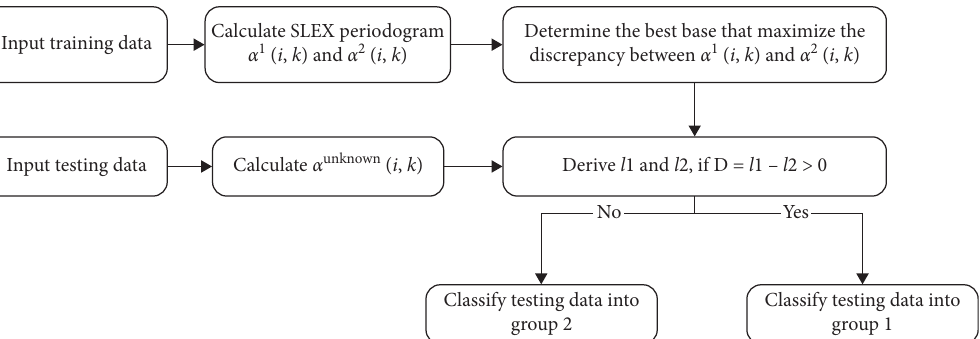
Figure 2: Flowchart of classification process, where training data with low lifetime are in group 1 and training data with high lifetime are in group 2.